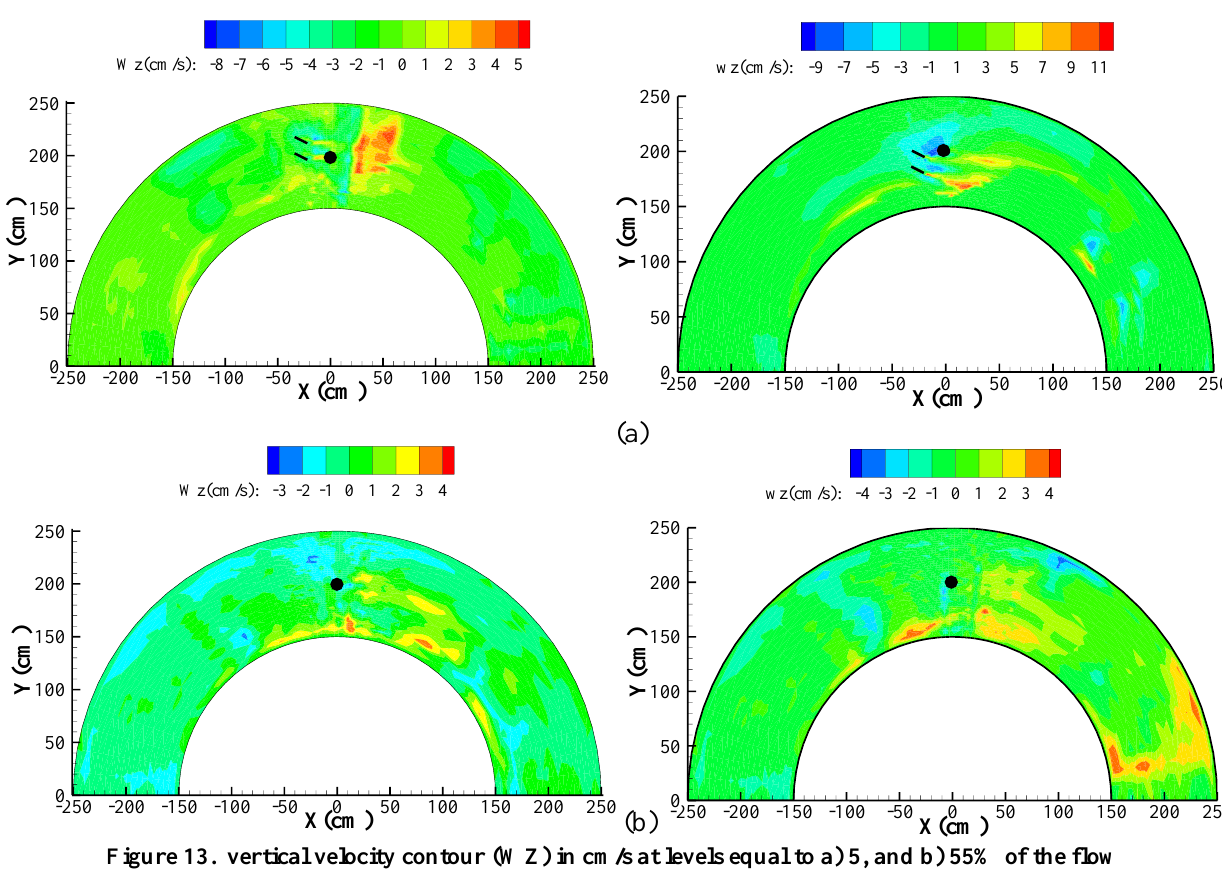
Figure 13. vertical velocity contour (WZ) in cm/s at levels equal to a) 5, and b) 55% of the flow depth at the beginning of the bend from the bed (PFV experiment on the right, and PSV experiment on the